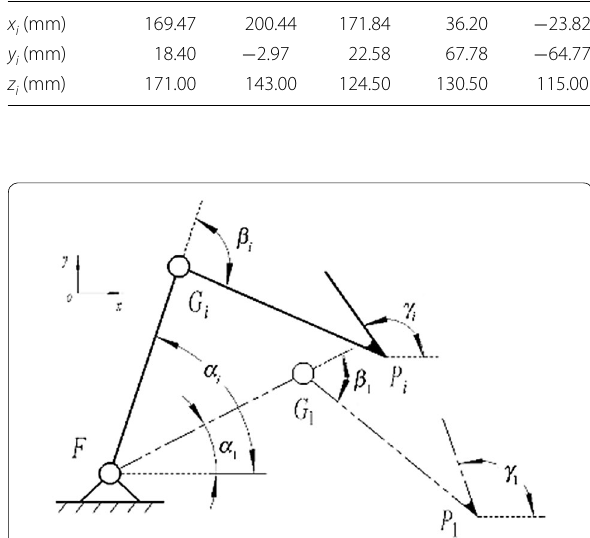
Figure 3 Schematic of the two-bar planar mechanism movement: FG 1 -rod I at key point 1, FG i - rod I at key point i , G 1 P 1 - rod II at key point 1, and G i P i - rod II at key point